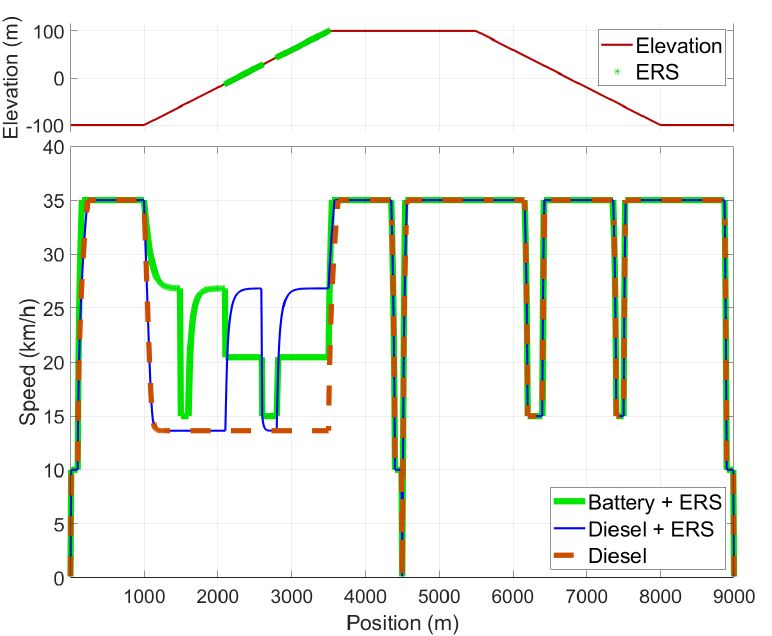
Figure 8. Speed of the vehicle with different drivetrain options for the Short 2 drive cycle. Elevation and ERS placement shown for reference.